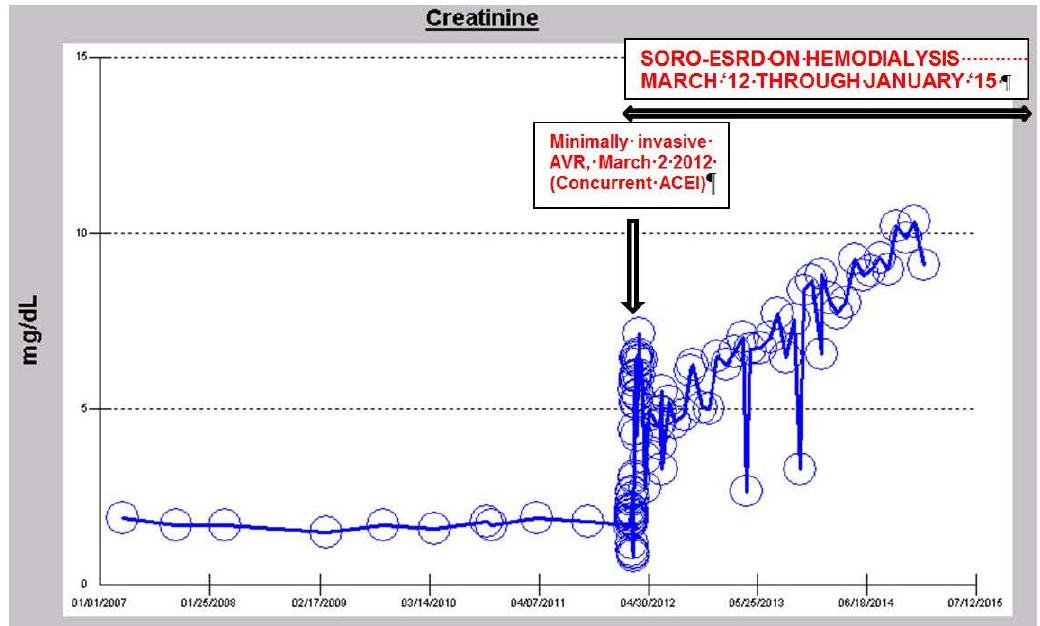
Figure 6. Serum creatinine trajectory, 2007–2014, with AKI in March 2012 in a 73-year-old morbidly obese, diabetic, hypertensive, CKD III Caucasian male following minimally invasive AVR for symptomatic aortic stenosis.